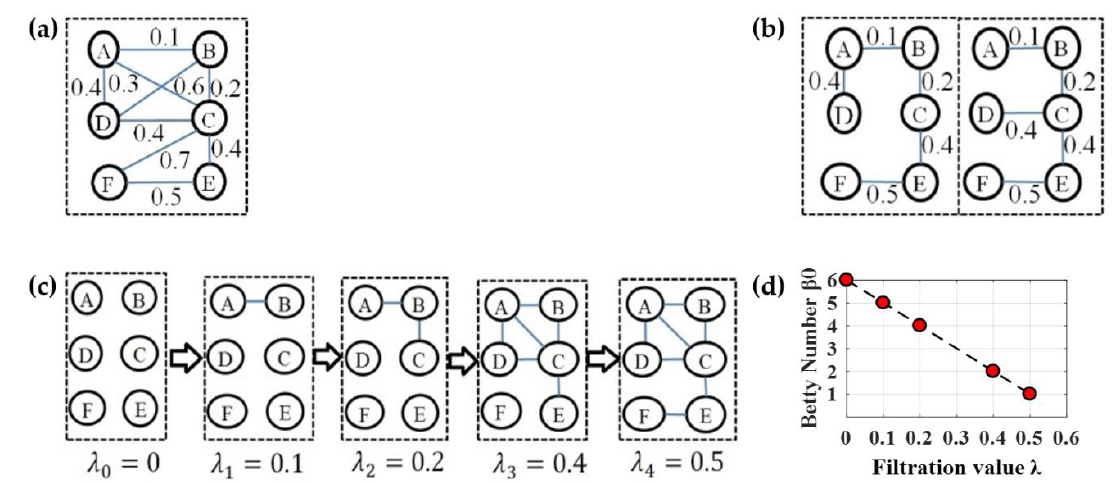
Figure 6. An example illustrating the persistent feature BNP from a weighted network. ( a ) An example network G . ( b ) Two possible minimum spanning trees (MSTs). ( c ) Multiscale network by graph filtration at all possible scales. ( d ) The Betti number 𝛽 0 plot (BNP)